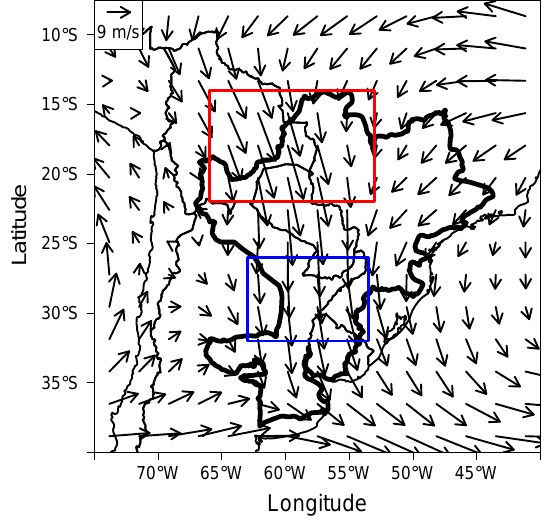
Fig. 3. Mean wind of north flow cases identified by the filtering method. The blue box represents the study area, the red box is an auxiliary region for the filter and the thick black contour delimits the La Plata